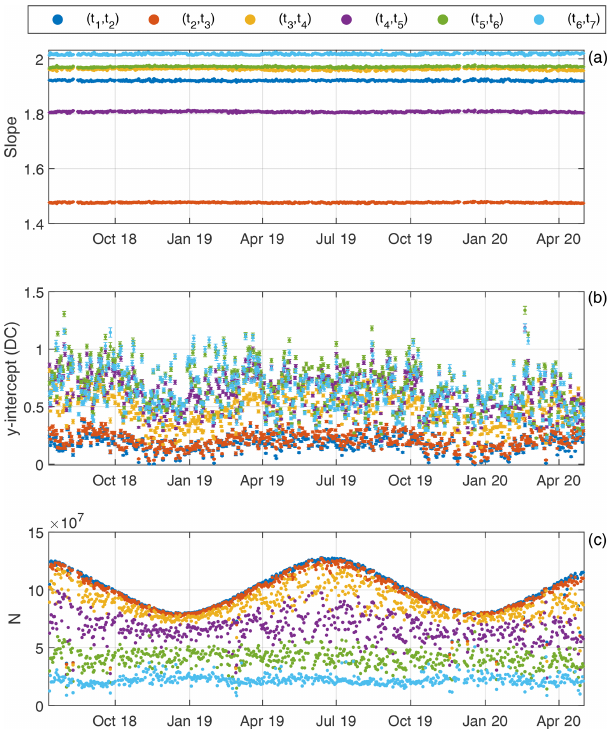
Figure 7. Time evolution of the (a) slope, (b) y intercept and (c) amount of used data ( N ) of the daily weighted least squares linear fits for different exposure time